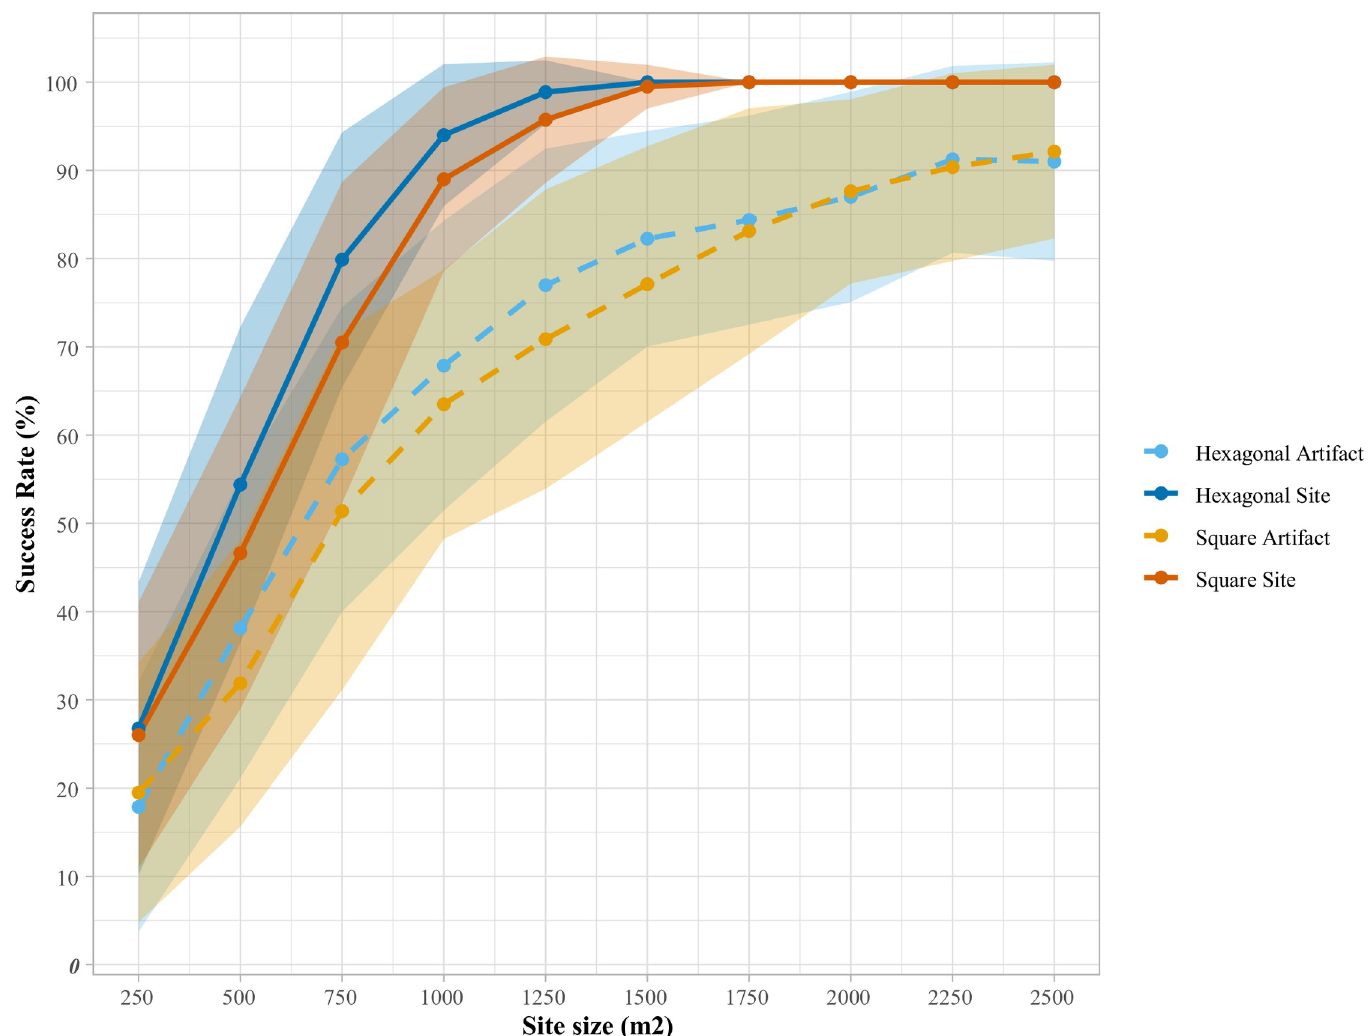
Fig 4. Comparison of square and hexagonal grid effectiveness, parameters as follows: 0.2 x 0.2 km survey region, eight randomly located sites, 5 artifacts/m 2 , uniform distribution, up to 50% overlap between sites, 100 simulations. For both square and hexagonal grids, an inter-unit spacing of 33 m was specified, with site areas ranging from 250–2500 m 2